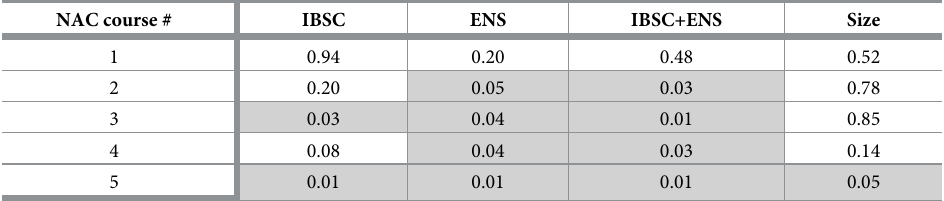
Table 1. p -values for treatment response classification based on ENS, IBSC, IBSC + ENS, and tumor size at each NAC treatment stage. p < 0.05 is marked in